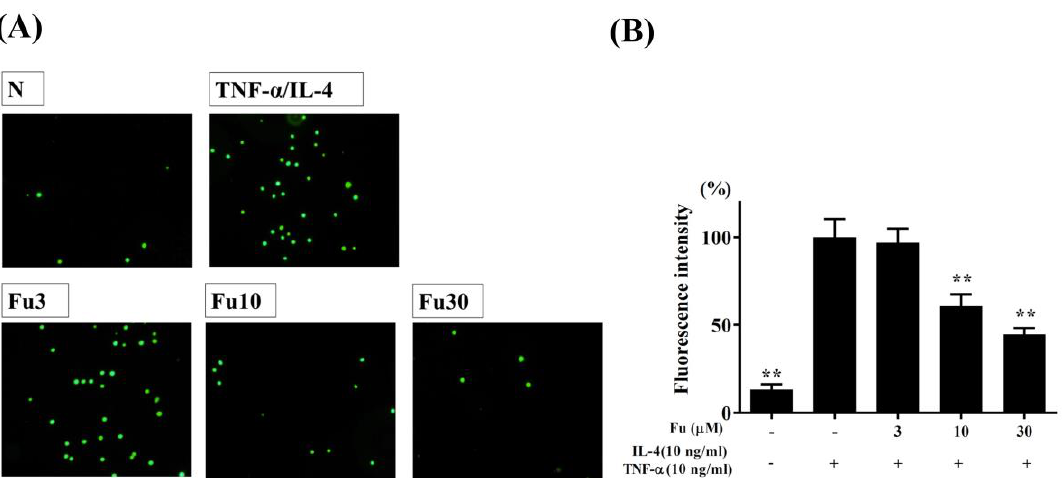
Figure 2. Fucoxanthin (Fu) inhibited THP-1 cell adherence to activated BEAS-2B cells. ( A ) Fluorescence microscopy images of THP-1 cells labeled with calcein-AM and mixed with normal (N) and TNF- α /IL-4-activated BEAS-2B cells in the absence or presence of Fu. ( B ) Fluorescence intensity of monocytic cell adhesion to BEAS-2B cells. Three independent experiments were analyzed. Data are presented as the mean ± SEM. ** p < 0.01 compared to BEAS-2B cells stimulated with TNF- α and IL-4.